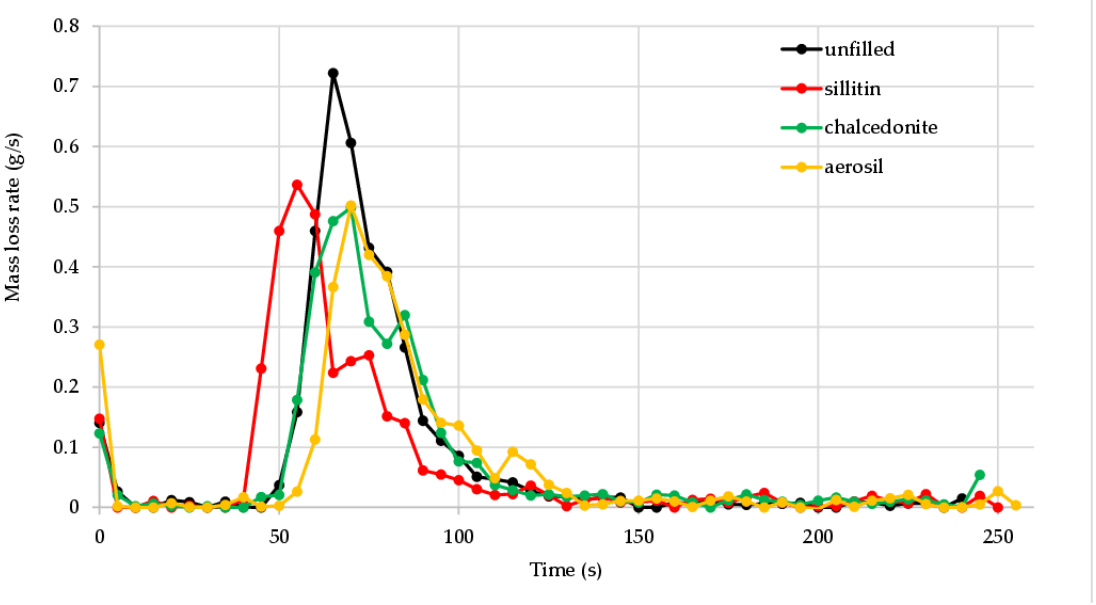
Figure 5. Mass loss rate (MLR) of unfilled or filled vulcanizates.